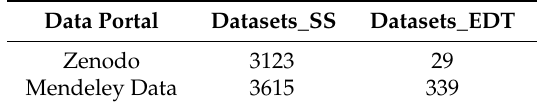
Table 2. Datasets concerned with Social Sciences and Educational Technology